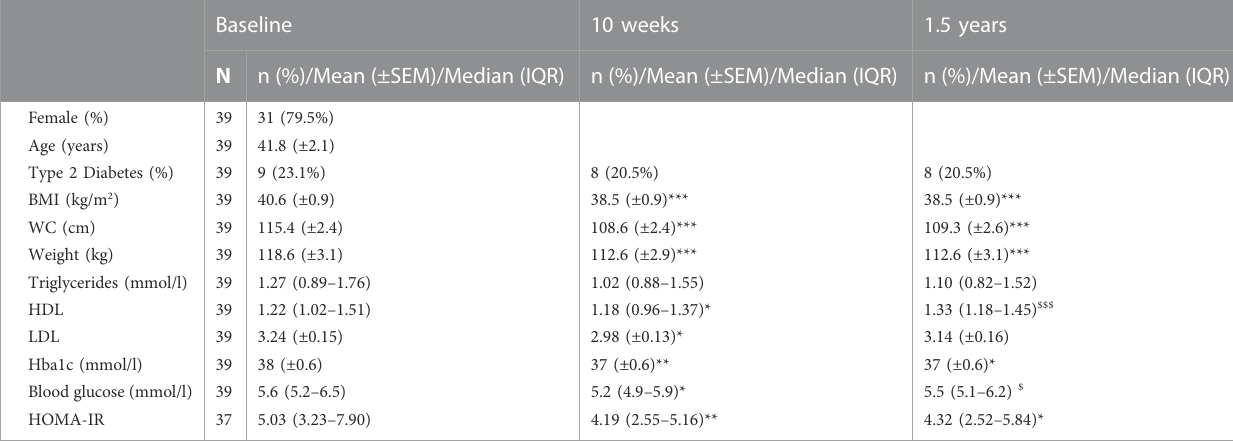
TABLE 2 Changes in anthropometrics in response to CLI.